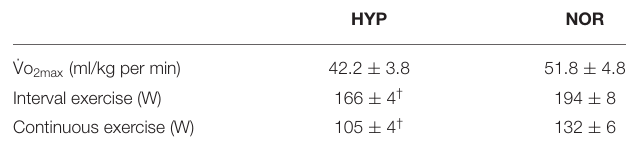
TABLE 1 | ˙Vo 2max and pedaling